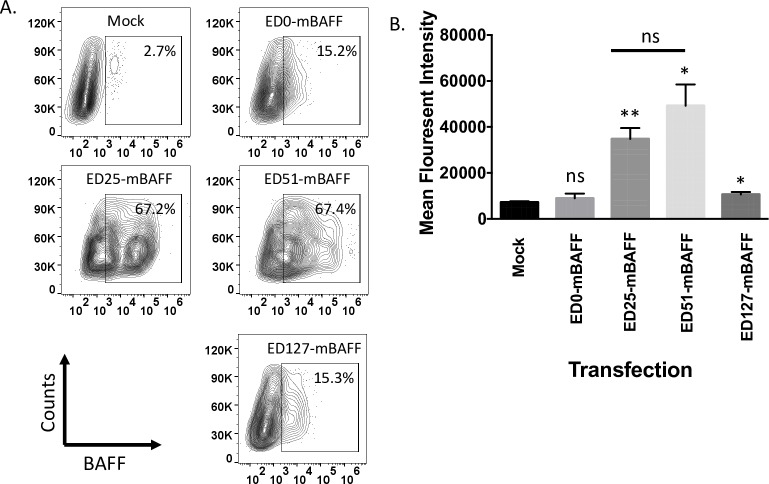
Twenty five or 51 amino acids of the membrane-proximal RABV G ED support the transport of BAFF to the surface of cells.BSR cells were transfected with pcDNA-ED0-mBAFF, pcDNA-ED25-mBAFF, pcDNA-ED51-mBAFF or pcDNA-ED127-mBAFF and three days later the cells were collected and fixed with 3% paraformaldehyde. Mock (PBS)-treated cells served as negative control cells. Cells were stained with mouse BAFF antibody conjugated to PE. Immunostained cells were analyzed by FACs analysis for BAFF surface expression. (A) Representative gating strategy to determine BAFF expression on the surface of BSR cells. (B) The MFI of surface expression of BAFF is summarized. To compare BAFF expression levels from each chimeric BAFF/RABV G fusion protein to mock-treated cells, an unpaired two-tailed Student’s t test was used (*p≤0.05; **p≤0.01; ns = not significant; N = 3 from 2 independent experiments completed in duplicate).